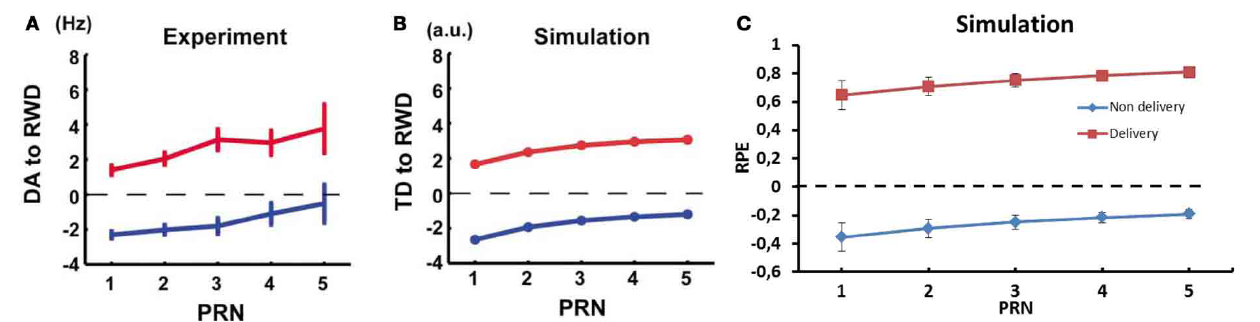
FIGURE 10 | Dynamics of RPE relatively to previous reward history and trial outcome. (A) Experimental results of the firing rate of dopaminergic neurons from monkey and (B) TD error results from a conventional TD model; reward omission (blue), reward delivery (red). Reproduced from Nakahara et al. (2004) (C) RPE dynamic relative to PRN from our